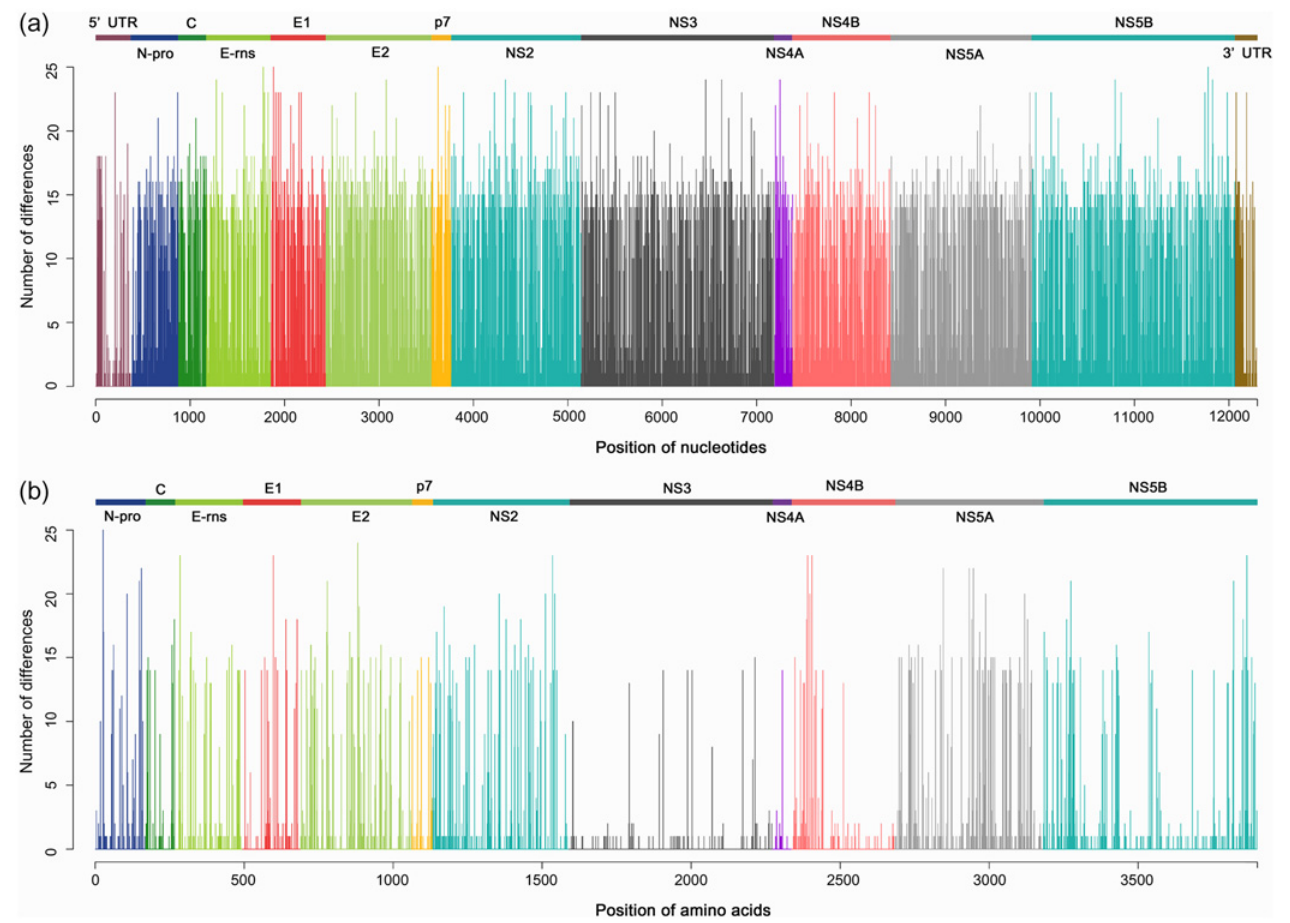
Fig 1. Variable site plots for nucleotide (a) and amino acid (b) sequence of 37 CSFVs. The number of differences at each site represents the number of variable isolates estimated with multiple sequence alignment. Each color indicates a different genomic